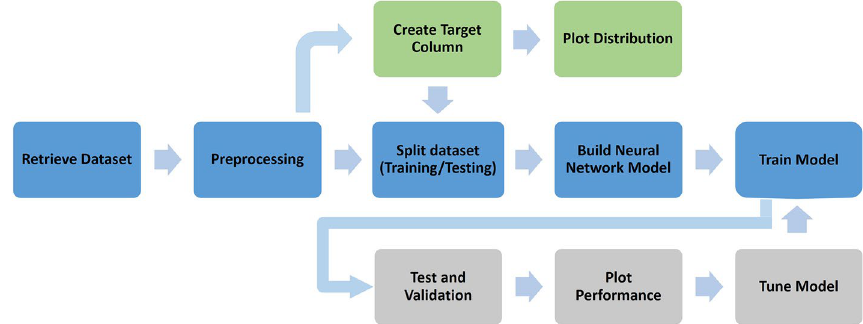
Fig. 1 COVID‑19 patient health monitoring workflow